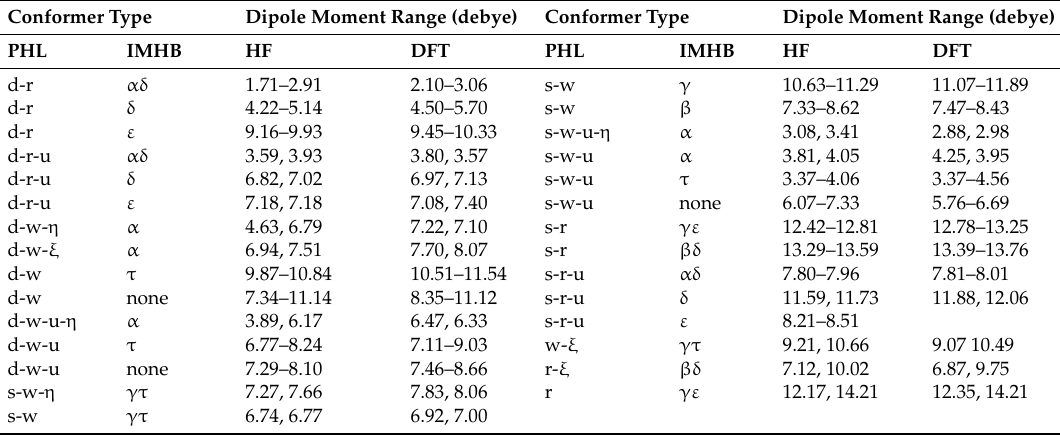
Table 7. Ranges of the dipole moment (debye) of the calculated conformers of arzanol. HF/6-31G(d,p) and DFT/B3LYP/6-31+G(d,p) results in vacuo, respectively denoted as HF and DFT in the column headings. The types of conformers are characterised by the features that prove relevant in relation to the ranges of the given dipole moment, i.e., the first IHB and the orientations of the other phenol OH (under the PHL heading) and the types and combinations of IMHB (under the IMHB heading). When only two values are available for a given type, they are both reported, separated by a comma, and in the same sequence in the HF and DFT